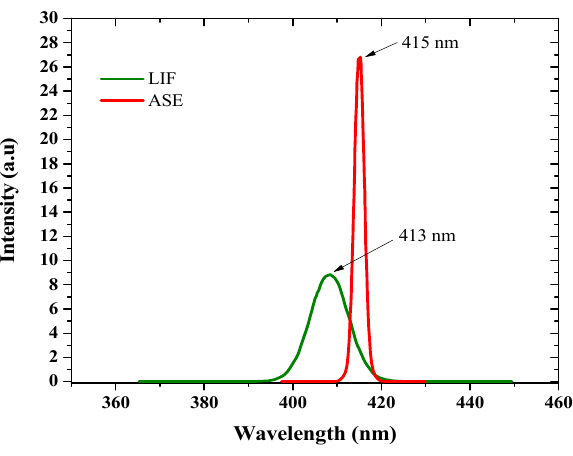
Figure 5. ASE Spectrum of PFO-co-pX in THF.